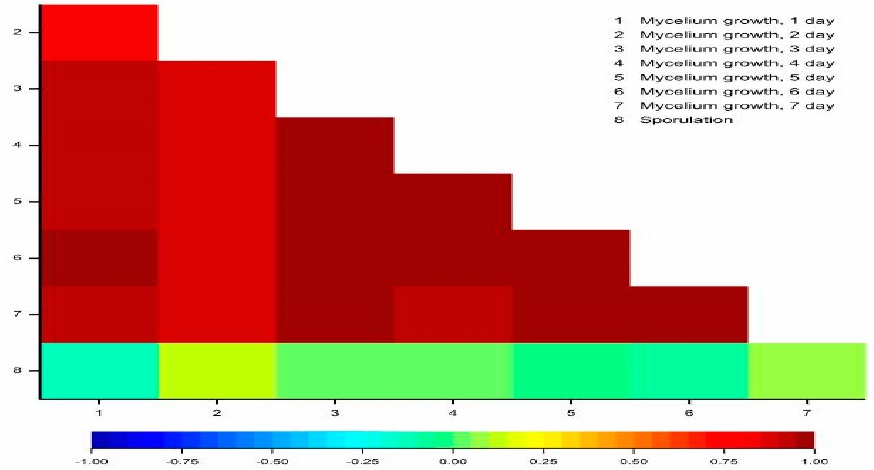
Figure 7. Heatmap matrix for linear Pearson’s correlation coefficients between mycelium growth (observed in 1–7 days) and sporulation ( r cr = 0.3125).